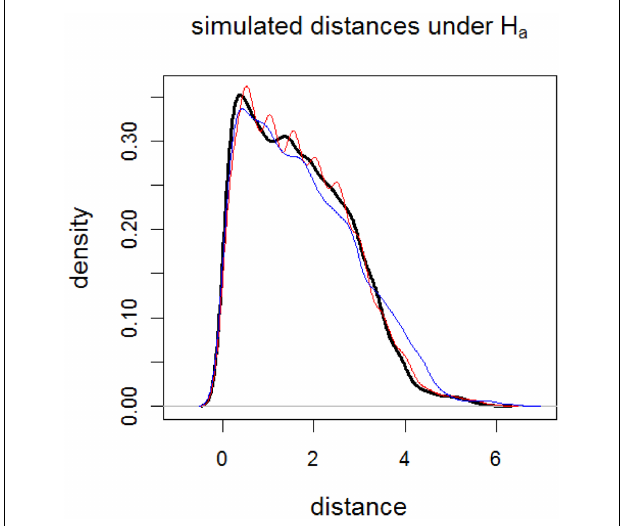
FIGURE 9 | Plots of the kernel density estimates of the Monte Carlo distances under the alternative H a : r x = 1.0, r y = 1.2, r z = 1.0, and η x = 0, η η y = 0, z = 50 .Thick solid black line is for sample X , thin solid red line is for sample Y , and thin solid blue line is for sample Z .